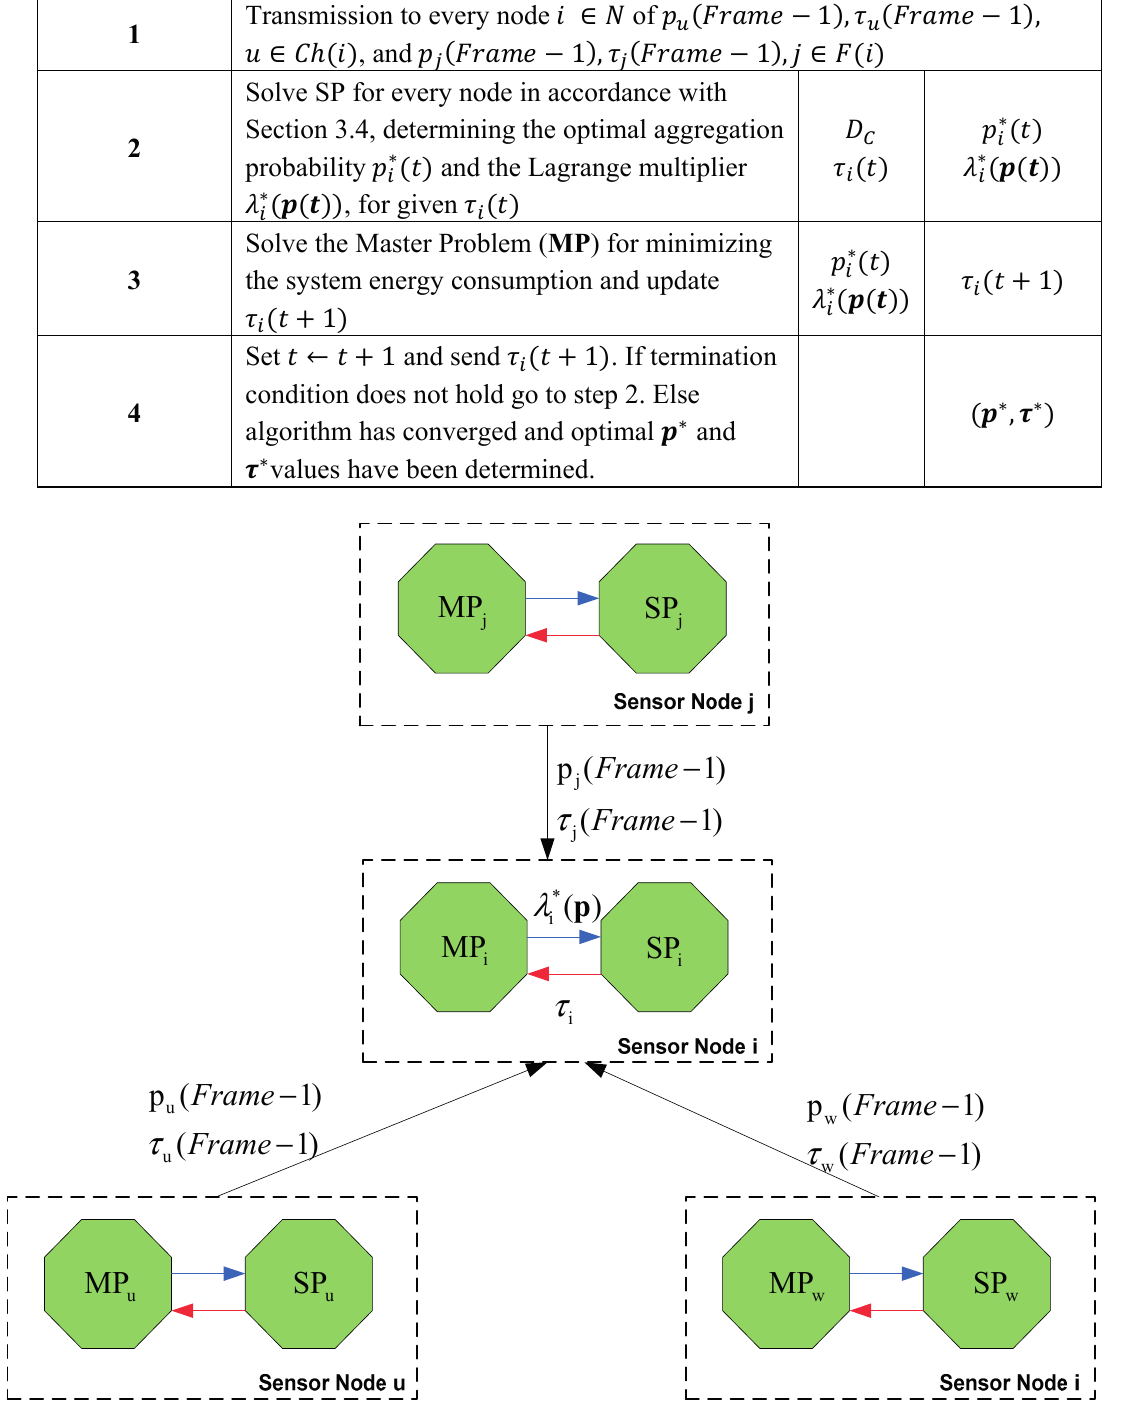
Figure 2. Schematic representation of the AEM